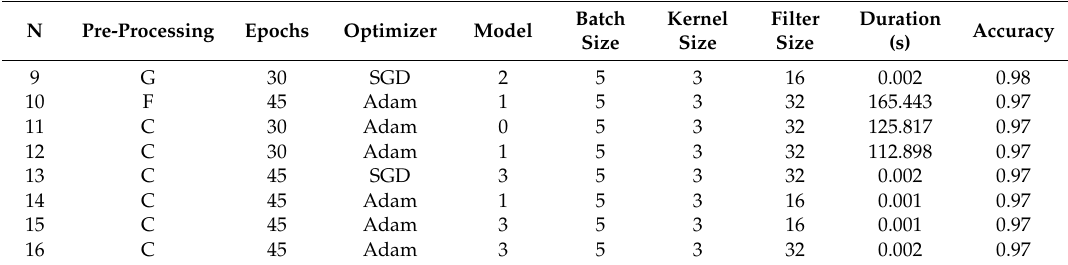
Table 4. CNN tests with result extracts of augmentation